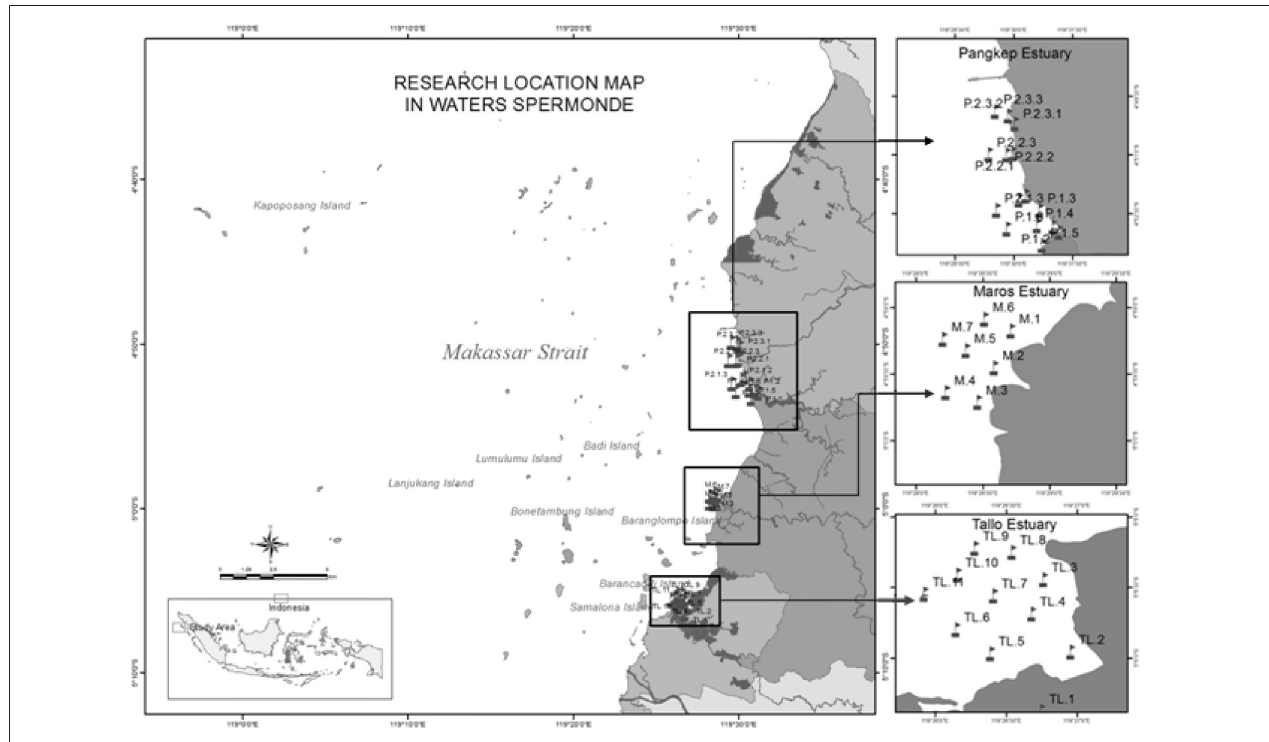
FIGURE 1 | Map of research locations in the waters on the west coast of South Sulawesi, sampling location is marked with a box. TL, Tallo estuary; M, Maros estuary; P, Pangkep estuary. 1, 2, 3,...,11, sampling location points.